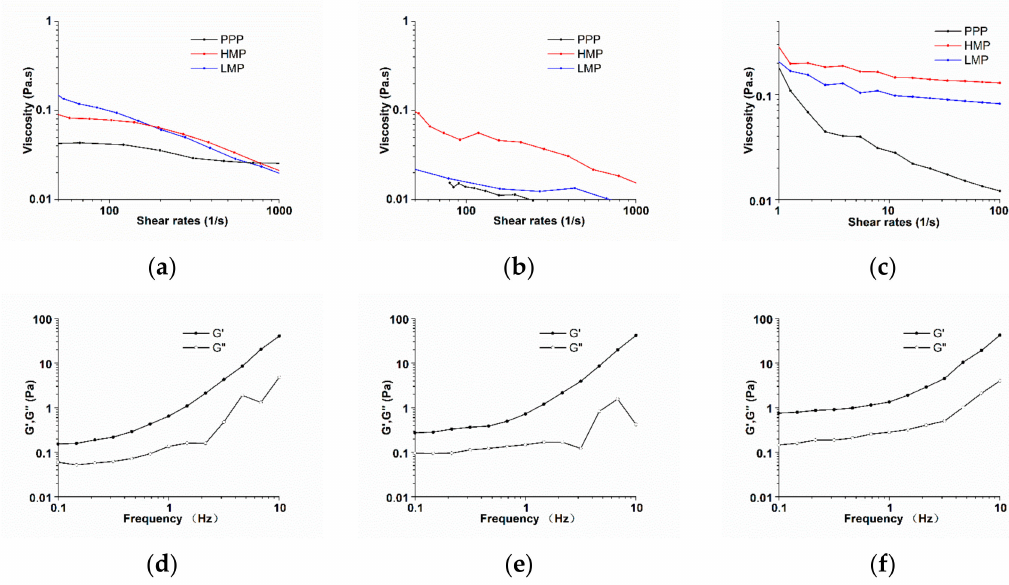
Figure 3. Steady shear flow curves: ( a ) of AMDs prepared with 0.5% di ff erent pectic polysaccharides, ( b ) serum of AMDs prepared with 0.5% di ff erent stabilizers, ( c ) solution of 0.5% PPP, HMP, LMP; The frequency sweep (0.1–10 Hz) of AMDs prepared with 0.5% di ff erent stabilizers: ( d ) PPP, ( e ) HMP, ( f ) LMP.